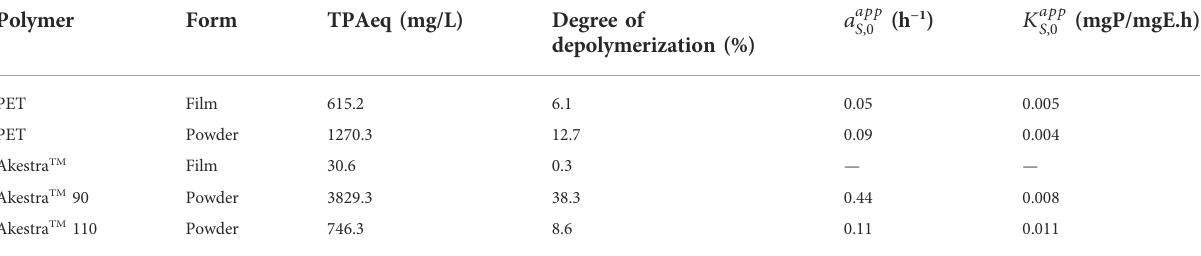
TABLE 2 Depolymerization of different polyesters after 235 h of incubation with HiCut.